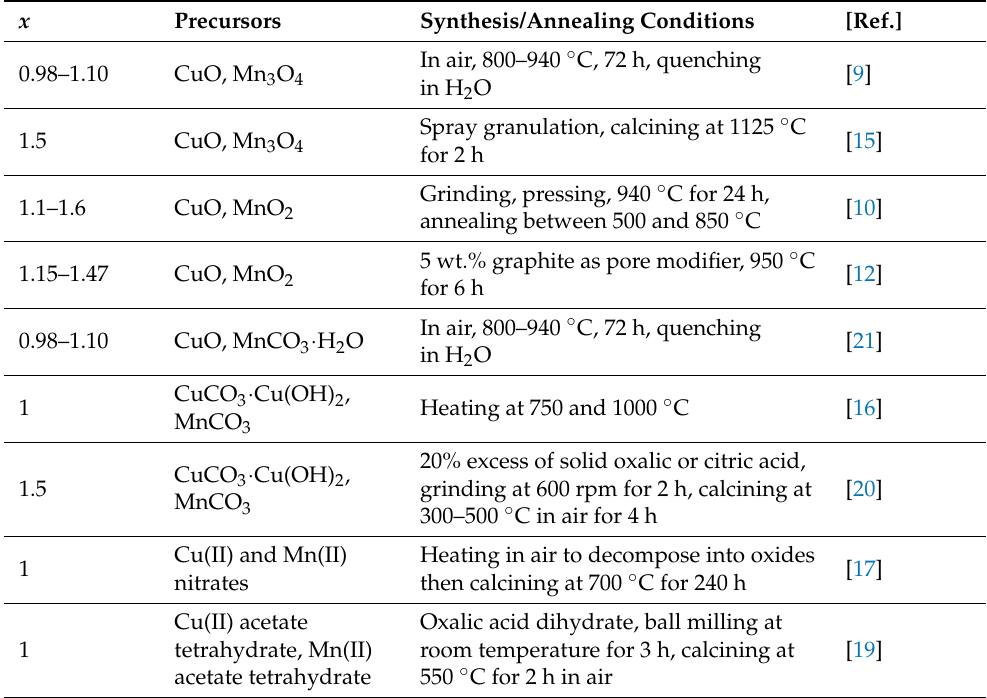
Table 1. Synthesis conditions of Cu x Mn 3 − x O 4 catalysts with solid-phase